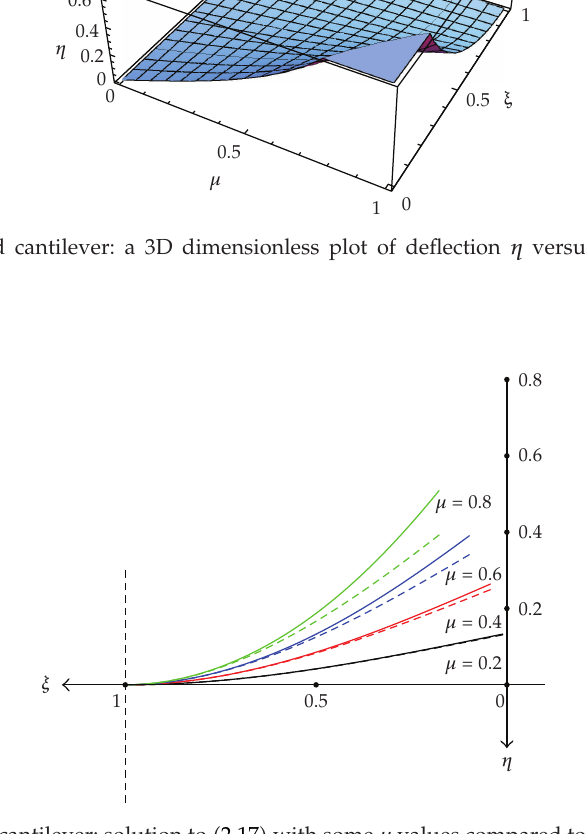
Figure 5: The sheared cantilever: solution to (cid:3) 2.17 (cid:4) with some μ values compared to the dotted lines of the linearized